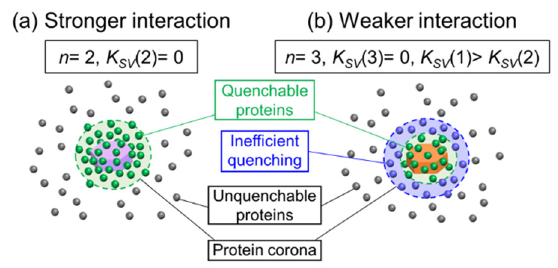
Table S2 in Supplementary Materials, where the not linear modified Stern–Volmer plot was thought to be due to the large error at low concentrations of LDH-S(0).